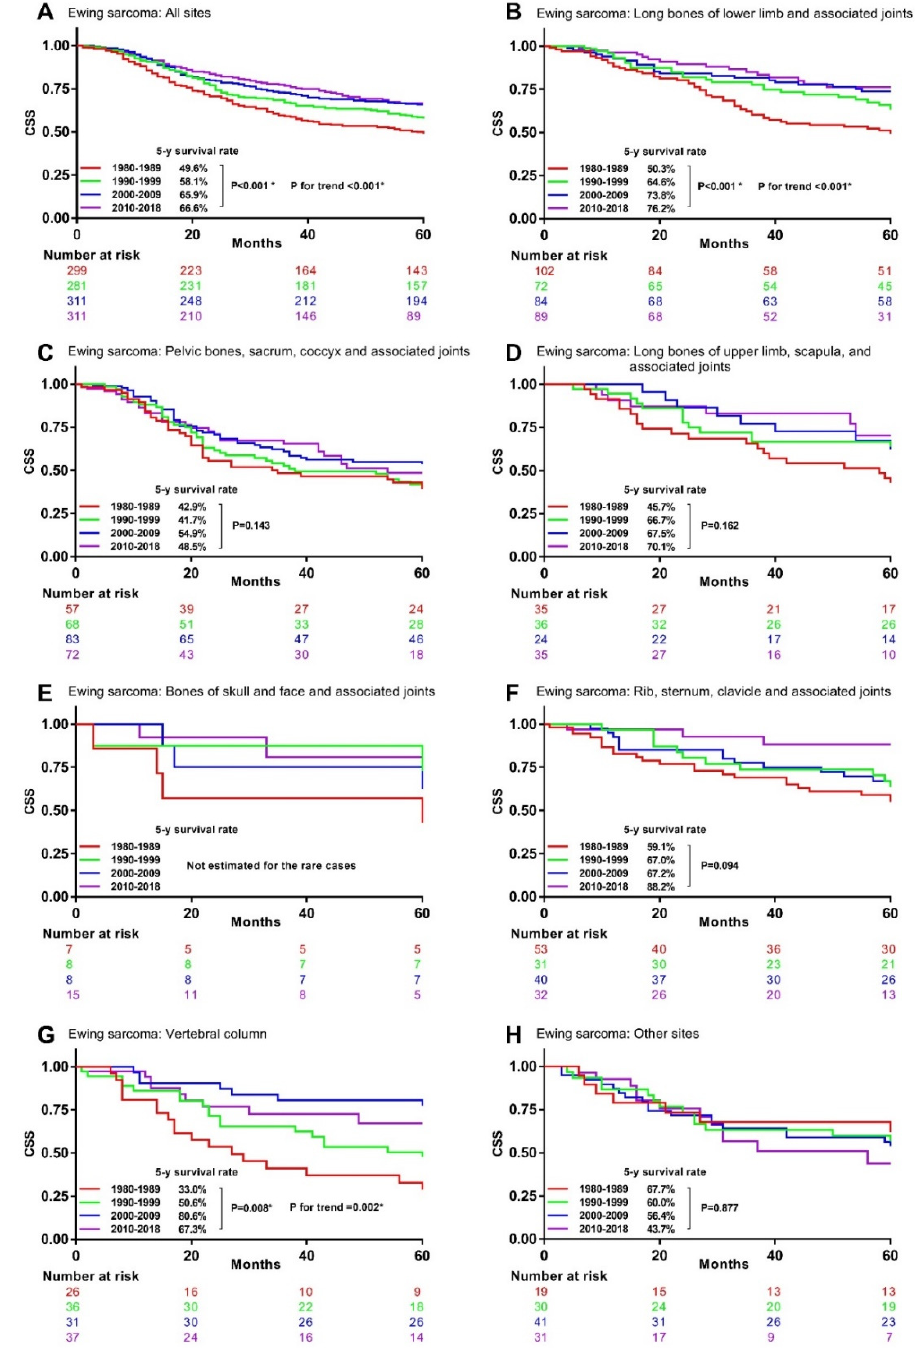
Figure 5. Kaplan–Meier curves showing 5-year CSS rates trend by decade in Ewing sarcoma with different primary sites. CSS: bone sarcomas-specific survival. * Statistically significant. ( A ), All site ( B ), Long bones of lower limb and associated joints ( C ), Pelvic bones, sacrum, coccyx and associated joints ( D ), Long bones of upper limb, scapula, and associated joints ( E ), Bones of skull and face and associated joints ( F ), Rib, sternum, clavicle and associated joints ( G ), Vertebral column ( H ) Other